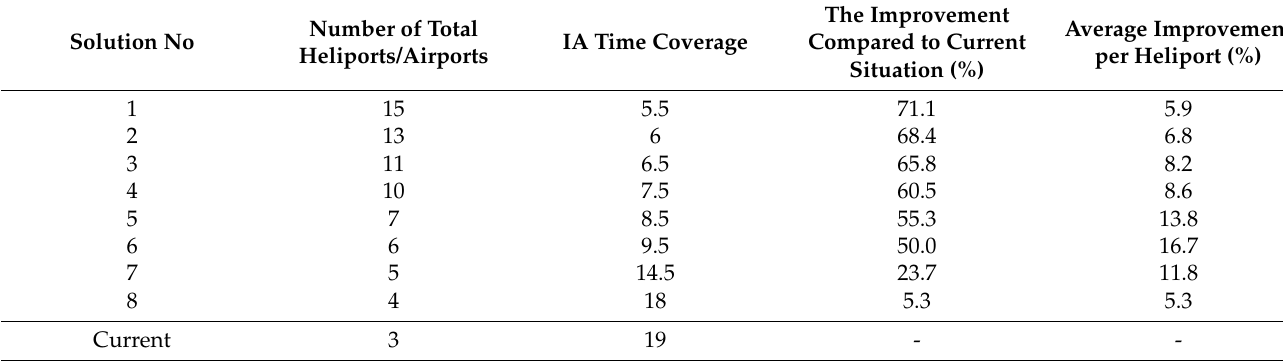
Figure 18. Pareto optimal solutions (heliports). Table 1. Improvements in the Pareto optimal results (heliport).